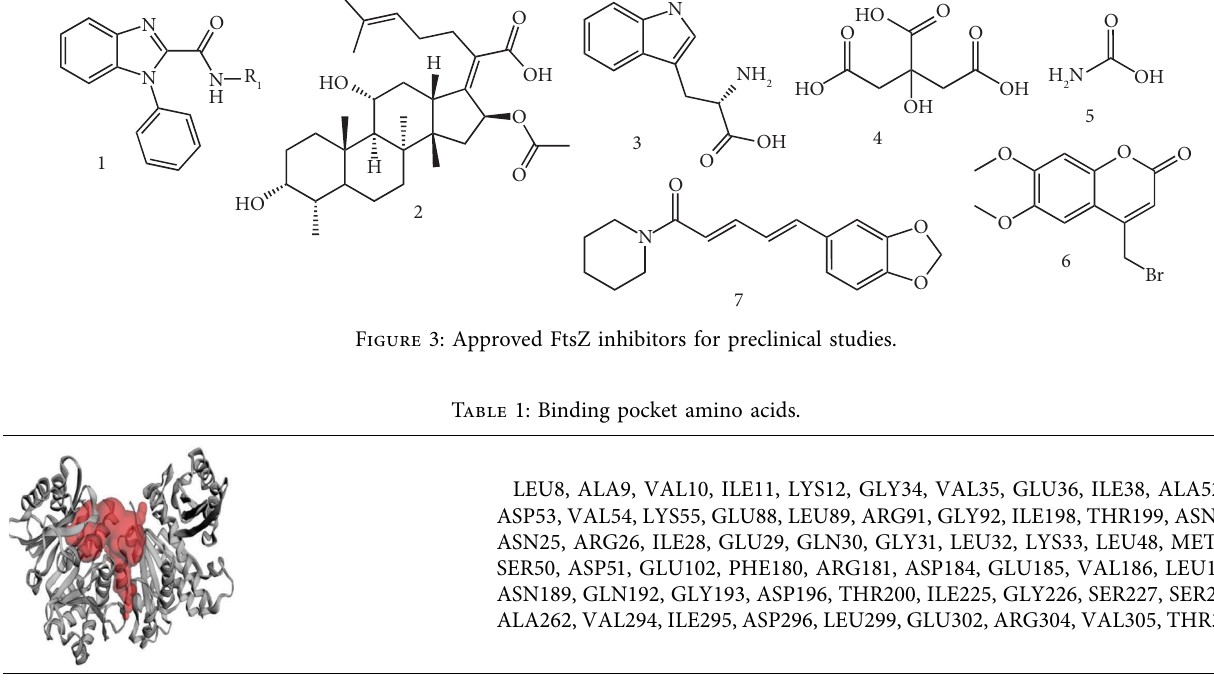
Prediction of Pharmacokinetic Parameters.